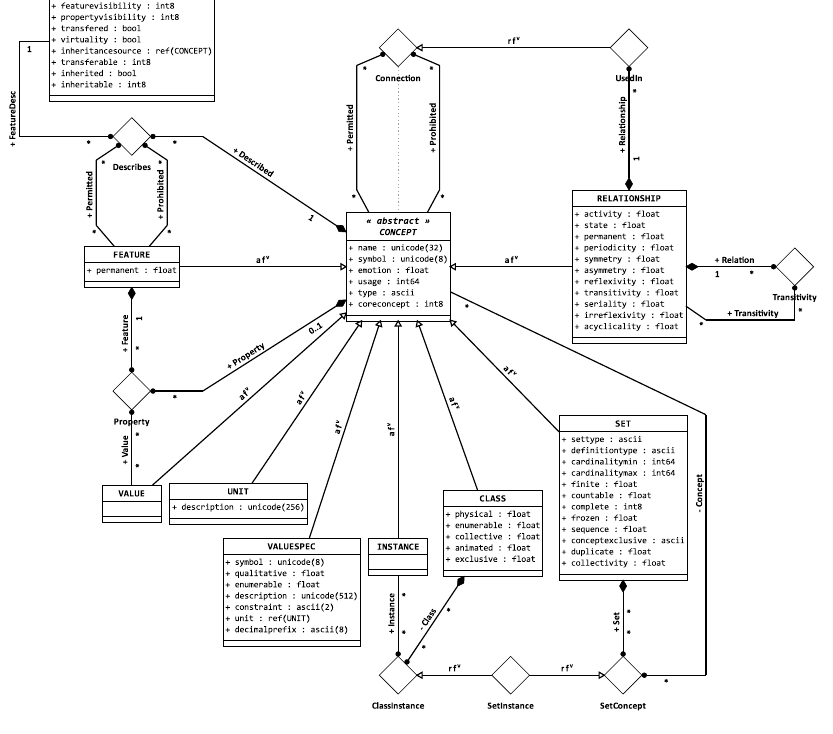
Fig. 19. AML diagram of